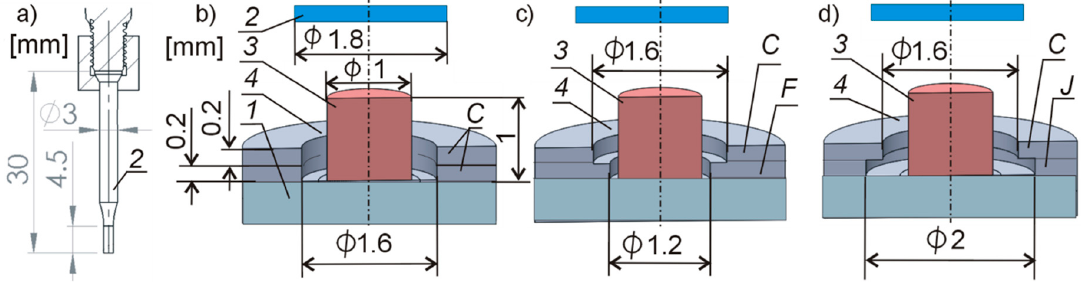
Figure 2. Tools included in the tests: ( a ) punch, ( b ) die CC: specimen “S3”, ( c ) die FC: specimen “S4”, and ( d ) die JC: specimen “S5”.